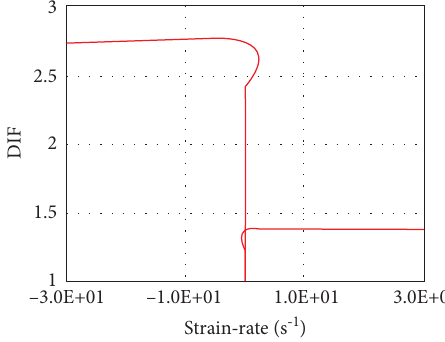
Figure 23: Relationship curve between strain rate and